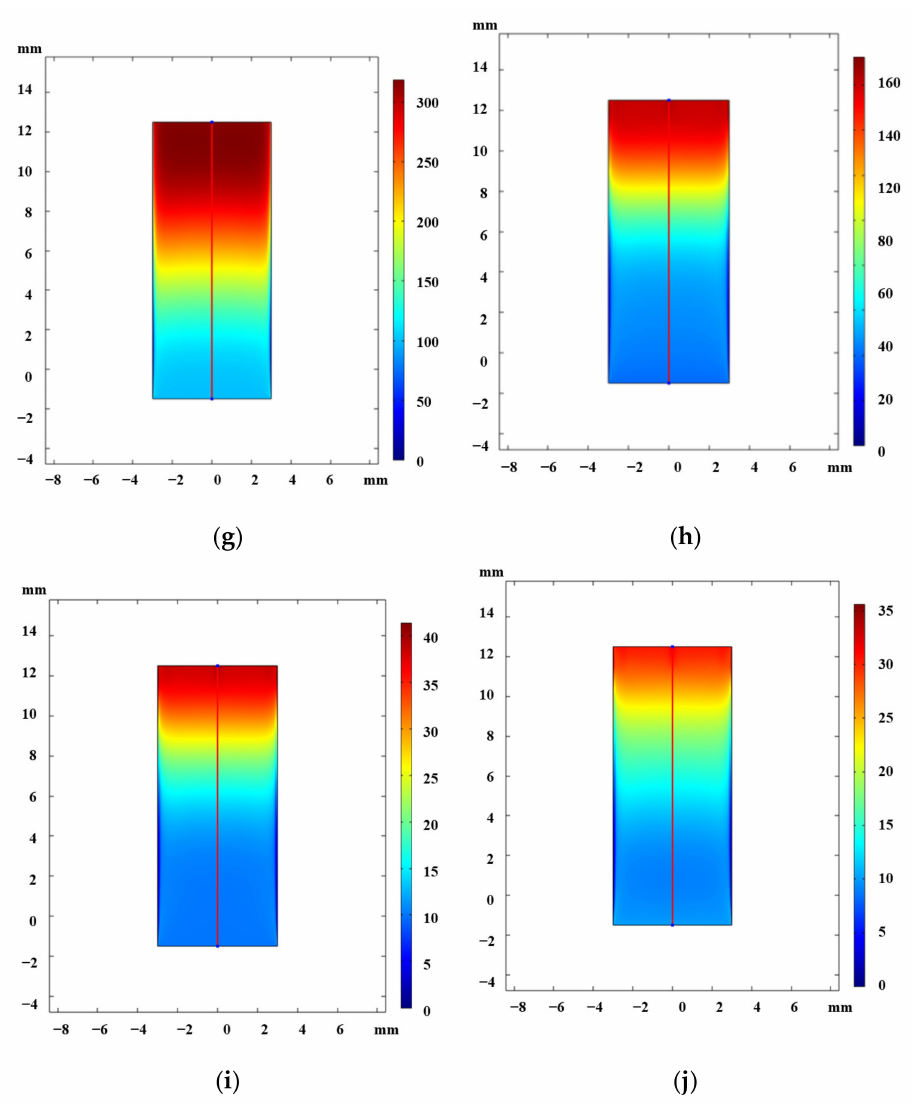
Figure 7. Velocity distribution cloud charts. ( a ) t = 1 µ s; ( b ) t = 3 µ s; ( c ) t = 6 µ s; ( d ) t = 9 µ s; ( e ) t = 12 µ s; ( f ) t = 15 µ s; ( g ) t = 18 µ s; ( h ) t = 21 µ s; ( i ) t = 24 µ s; ( j ) t = 27 µ